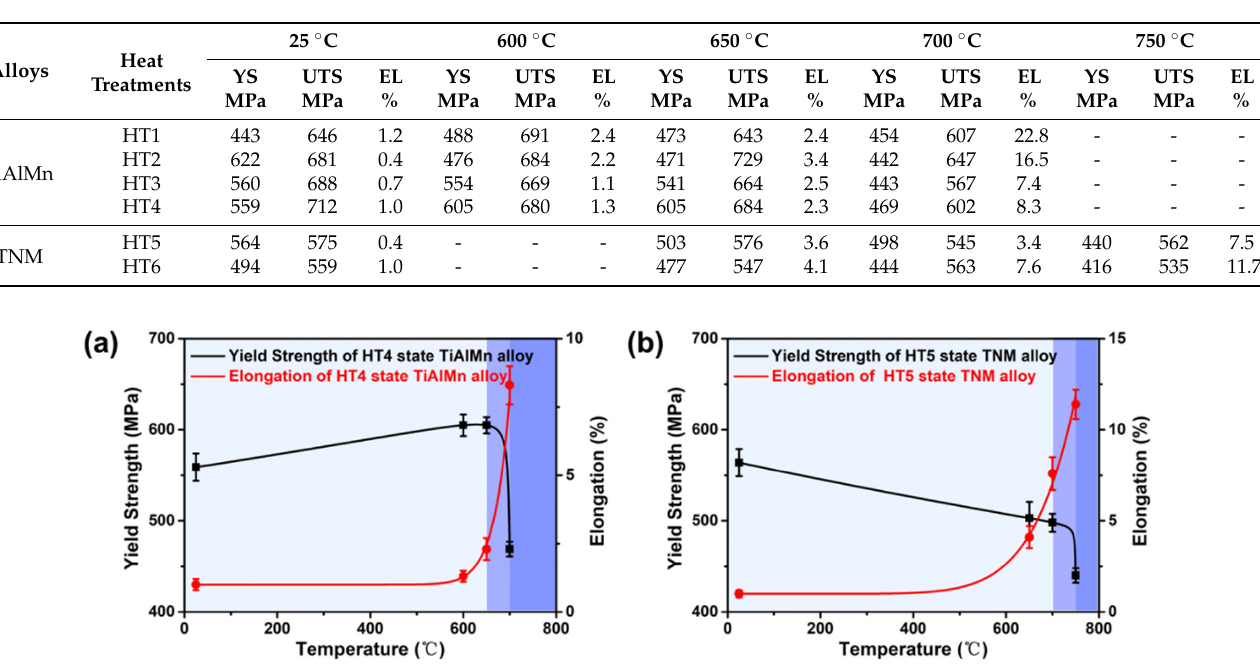
Table 4. Summary of the tensile properties of the heat-treated TiAlMn alloy and TNM alloy at different temperatures in Figure 9.